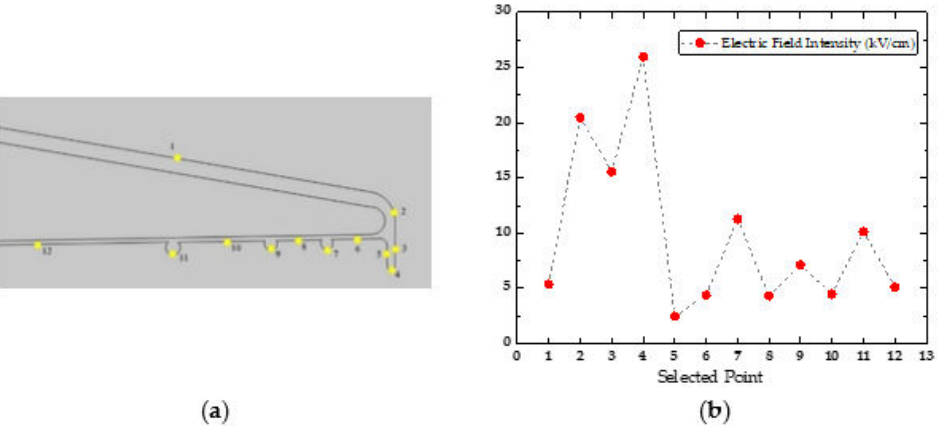
Figure 5. Values of electric field intensity of some selected points on the shed surface in the model with water-film and water-drops. ( a ) selected points on shed surface; ( b ) values of electric field intensity of the selected